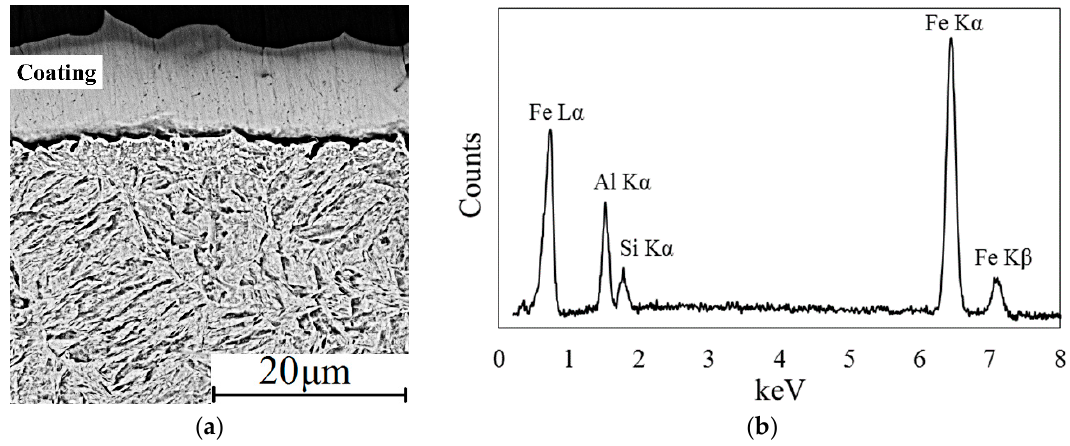
Figure 1. ( a ) SEM micrograph of the hot stamping boron steel sheets after the laboratory heat treatment and ( b ) EDS spectrum of the Fe/Al/Si coating.